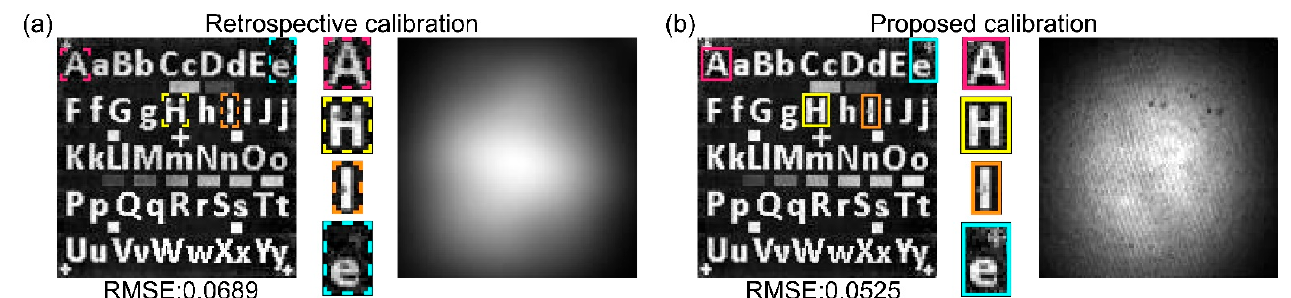
Figure 5. Experimental comparison. ( a ) Image calibrated using retrospective Gaussian filtering. Its illumination was estimated as a Gaussian distribution. The RMSE after calibration is 0.0689, and the local speckles on letters “H” and “I” were not eliminated. ( b ) Image calibrated using proposed method. Its illumination was measured. The RMSE after calibration is 0.0525, and the local speckles were eliminated.